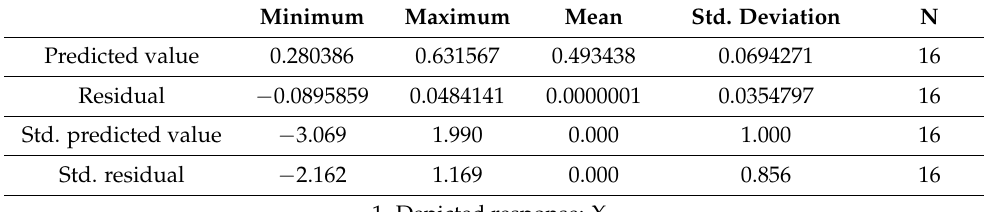
Table 22. Residuals Statistics for 3rd order polynomial model with two